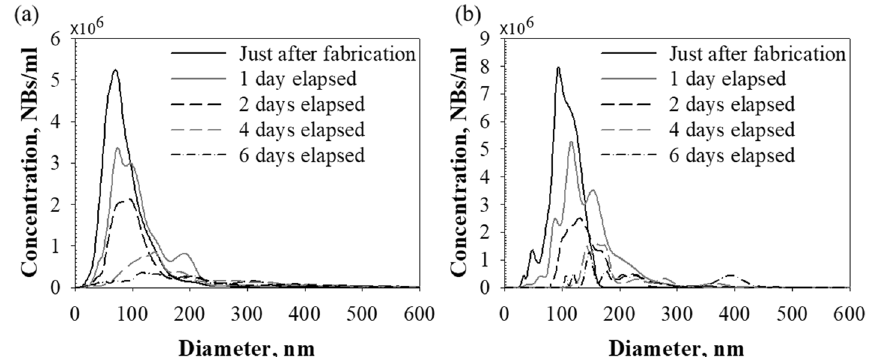
Figure 5. Size distribution of BNBs in water. Time evolution of size distribution: (a) case 1, (b) case 2. The initial size distribution of BNBs was in the range of 10–250 nm. The number of smaller particles decreased, while larger particles grew in size over time (approximately in the 10–530 nm range after 6